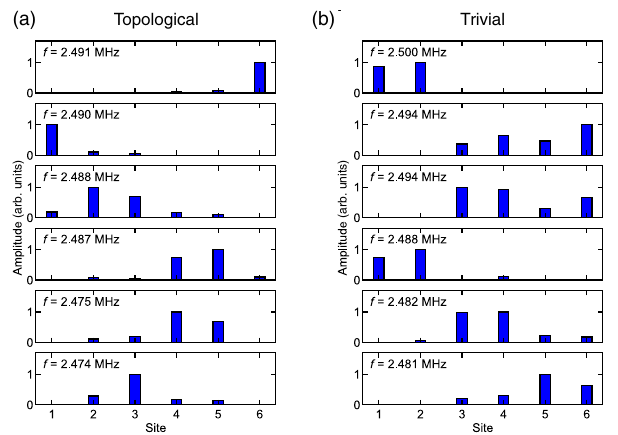
FIG. 17. Mode profiles of the collective perimeter modes. rms values of the Brownian motion of each site measured for all the collective perimeter modes of both topological (a) and trivial (b) chains of six square-shaped